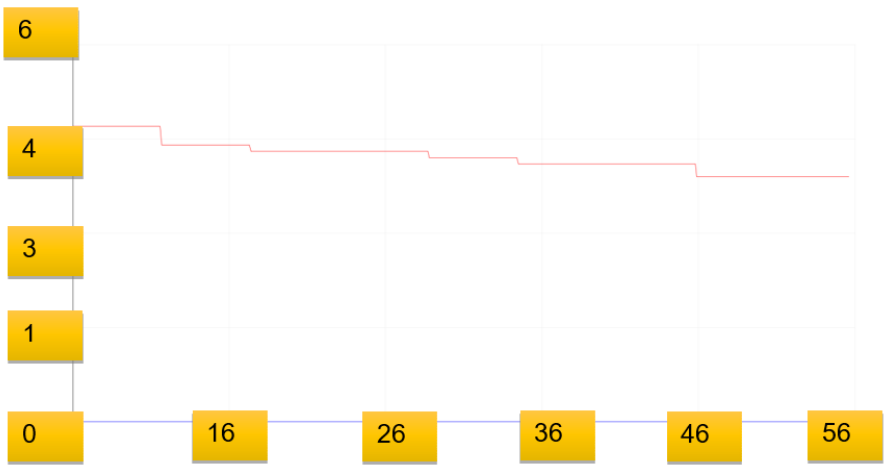
Figure 12. Humidity sensor in the presence of flame.